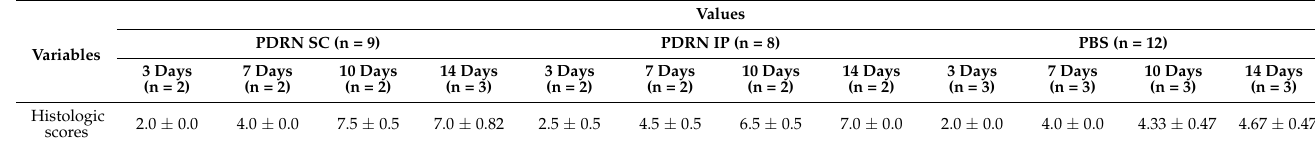
Figure 4. Histologic scores. At 10 days, the PDRN SC group had significantly higher histologic scores as compared with the PBS group (7.5 ± 0.5 versus 4.33 ± 0.47, respectively; p = 0.0055). Likewise, the PDRN IP group had significantly higher histologic scores as compared with the PBS (6.5 ± 0.5 versus 4.33 ± 0.47, respectively; p = 0.0158). At 14 days, the PDRN SC group had significantly higher histologic scores as compared with the PBS group (7.0 ± 0.82 versus 4.67 ± 0.47, respectively; p = 0.0248). Likewise, the PDRN IP group had significantly higher histologic scores as compared with the PBS group (7.0 ± 0.0 versus 4.67 ± 0.47, respectively; p = 0.0069).